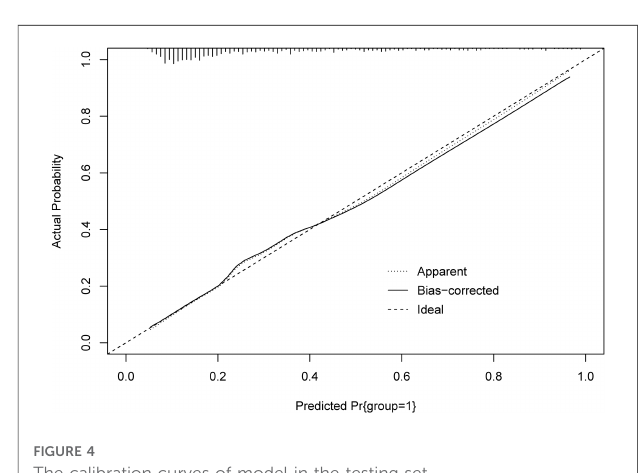
FIGURE 4 The calibration curves of model in the testing